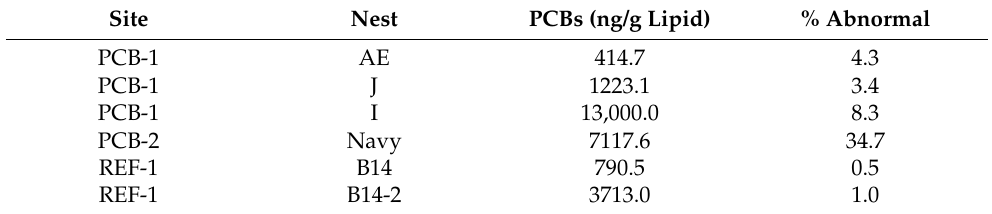
Table 7. PCB concentrations and % abnormalities in damselfish embryos collected from nests at three sites within Johnston Table 8. Mean (SD) mono-ortho and non-ortho PCB congener concentrations in damselfish tissues from Johnston Atoll. For NDs, the lipid-normalized mean of one half of the detection limit is given. In 2001, dioxins and furans were also measured in fish tissue. Mean TCDD TEQs are given for com- parison.